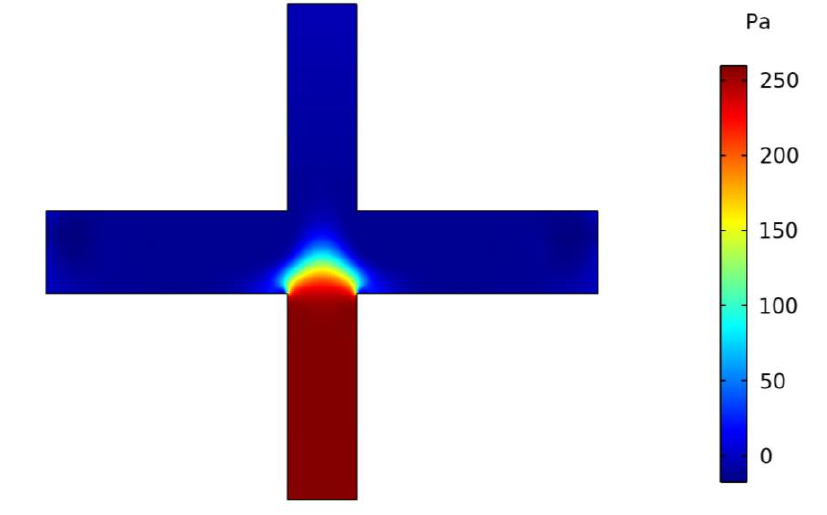
Figure 5. Pressure distribution in VI.